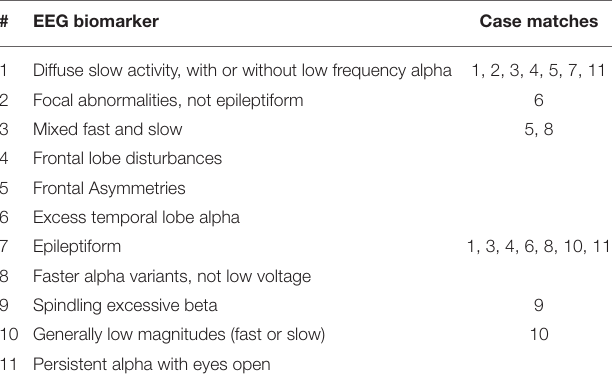
TABLE 3 | EEG endophenotypes (Johnstone et al., 2005), and prevalence in the sample population as estimated from clinical observations. # EEG